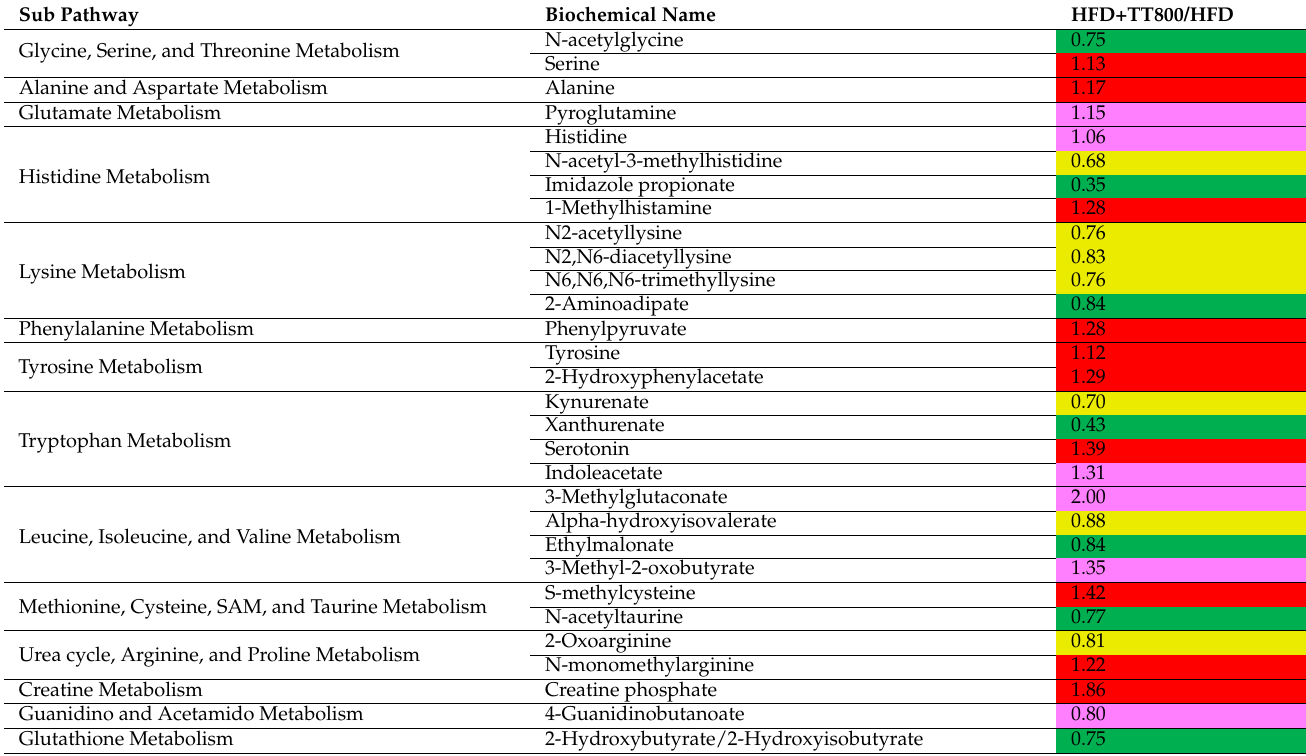
Table 4. Effects of TT supplementation on serum amino acid metabolites in mice fed HFD compared to the HFD control group. Sub